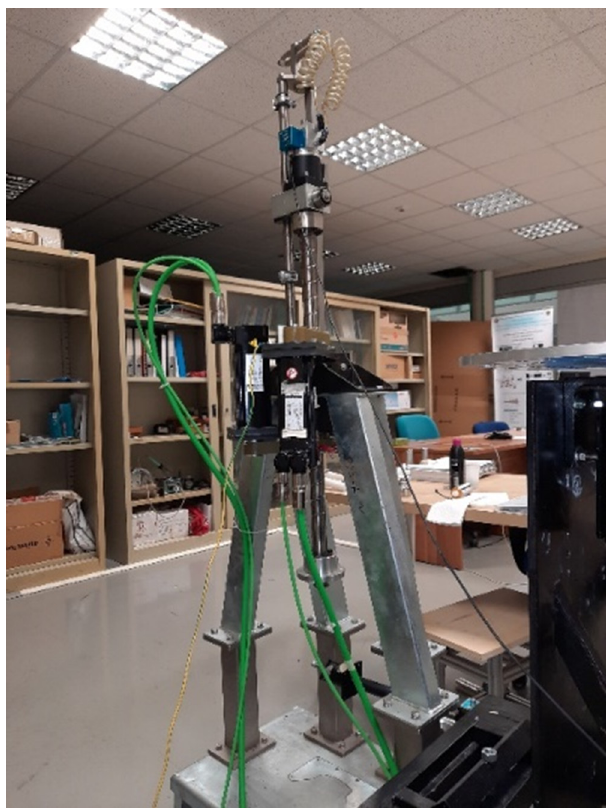
Fig. 2. Picture of the second test